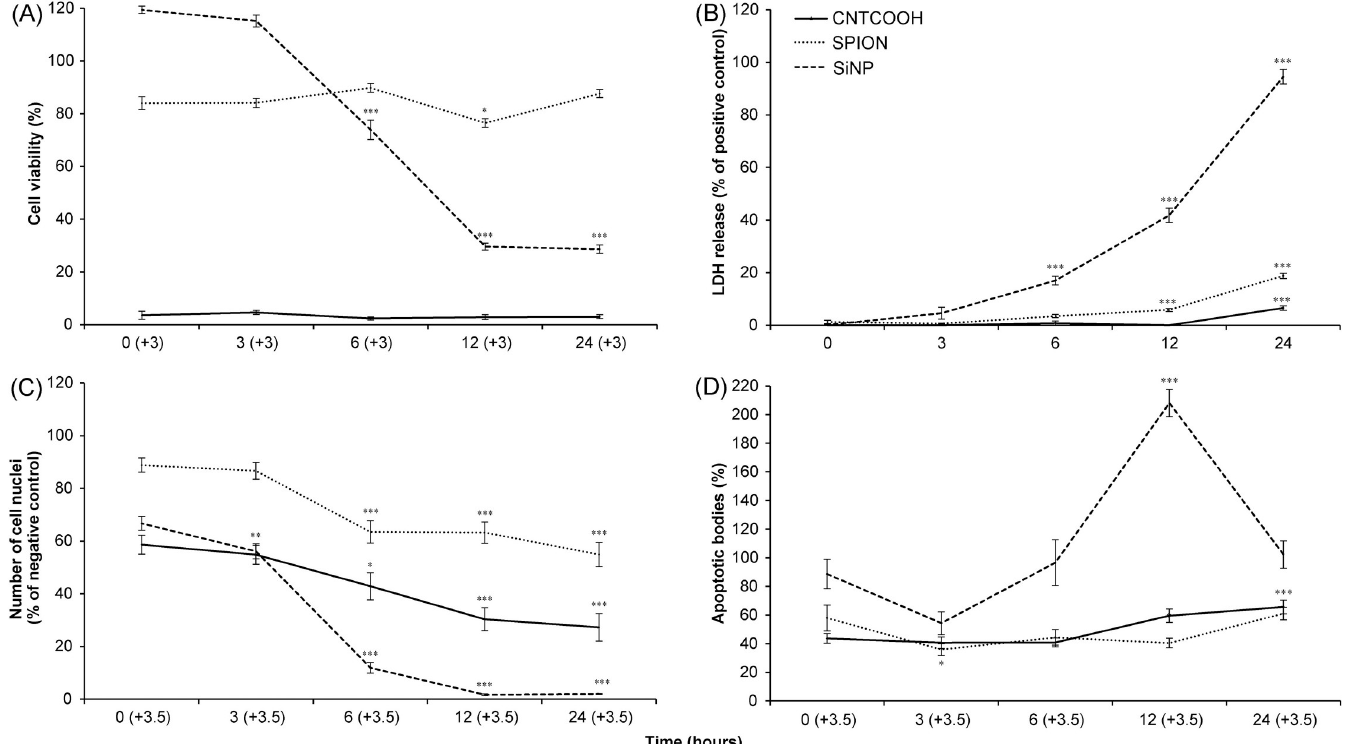
Fig 6. Time-response toxicity of different NPs towards HUVECs as measured by CDS assay. The HUVECs in the 96-well plate were treated with 100 μ g/ml of SPION, SiNP and CNTCOOH NPs for 0–24 h. The cell viability was measured by WST-8 assay (A), the cell necrosis was determined by LDH assay (B), and the number of intact cell nuclei (C) and number of apoptotic bodies (D) were counted by ImageJ software after the cells were stained with Hoechst 33342. Each treatment was performed in 6-plicate and the results (n = 3) are expressed as the means ± SEM as tested by one-way ANOVA followed by Dunnett’s test. ��� P < 0.001, �� P < 0.01, and � P < 0.05, versus the time point 0